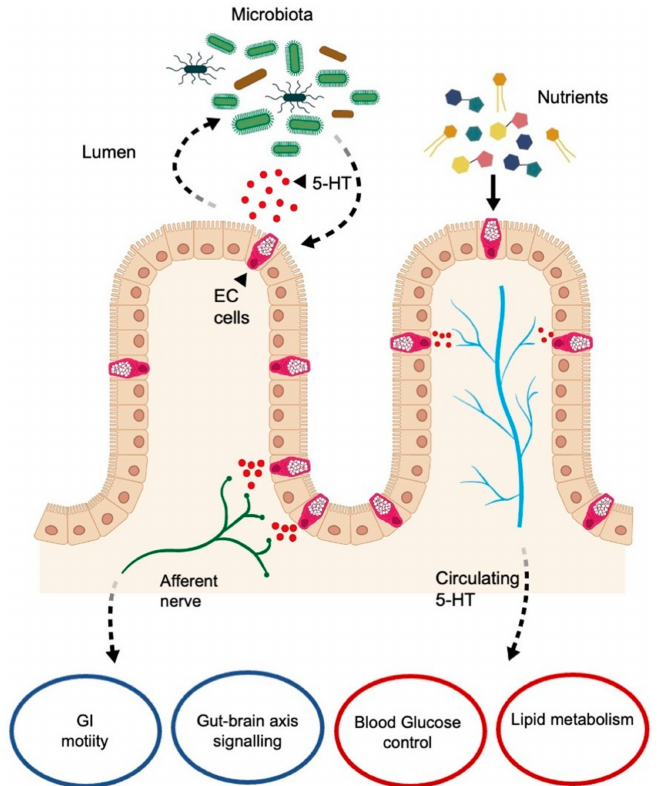
Figure 10. Schematic representation of the bidirectional relationship among ECs, enteric nervous system, 5-HT, nutrients, and microbiota. 5-HT released from EC cells can modulate the microbiota species, but moreover, once released in the blood stream, it could stimulate glucose and lipid metabolism. Basal 5-HT’s release can also activate vagal afferent fibers inducing intestinal motility and modulating the brain–gut axis signaling. EC cell: enterochromaffin cell; 5-HT: 5-hydroxytryptamine; GI: gastrointestinal. Black arrows and black dotted arrows represent the relationship between intestinal mucosa, the nervous system, the circulatory system and the lumen’s content. Modified from Jones et al., 2020